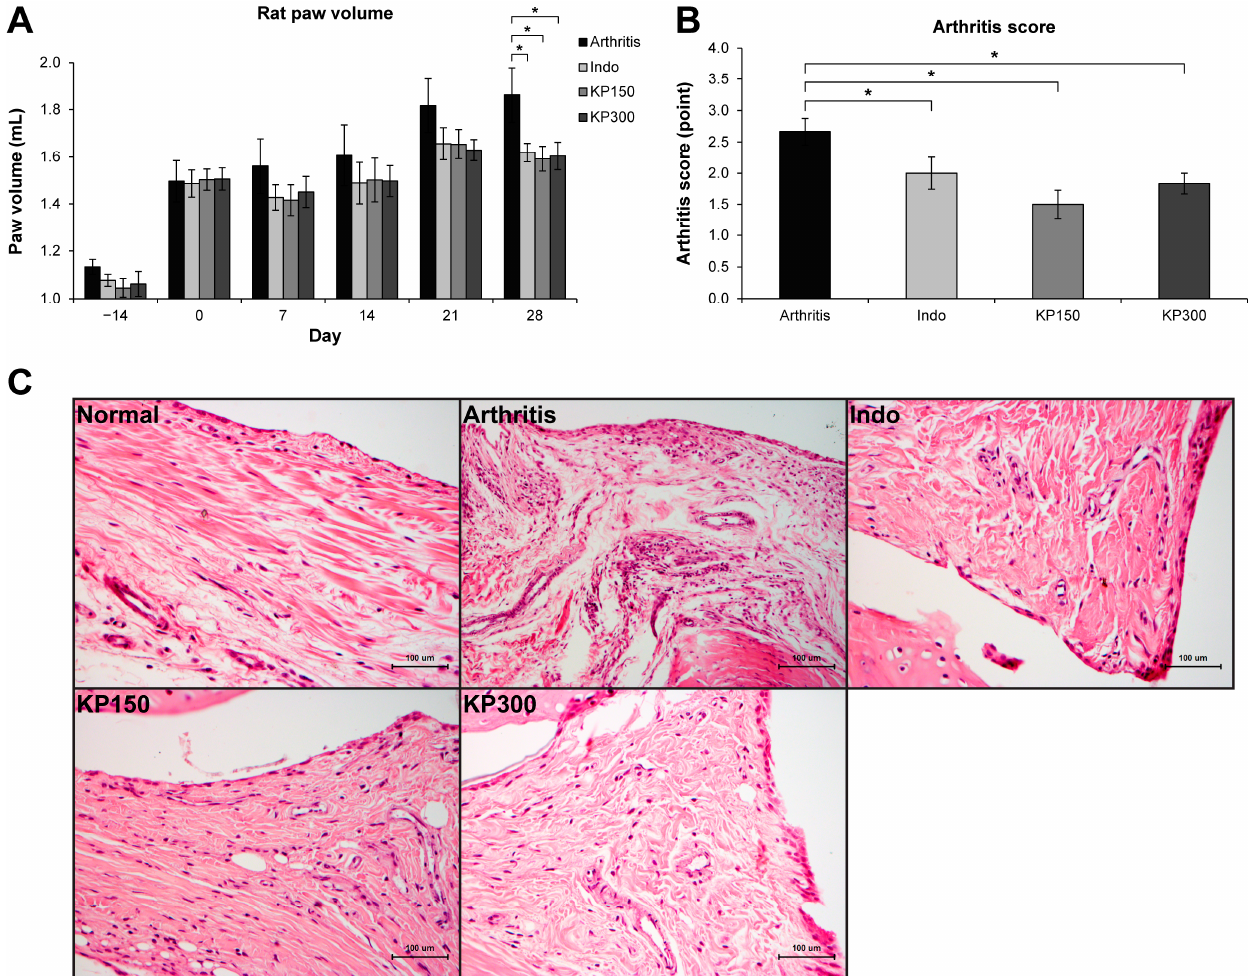
Figure 1. KP extract attenuates CFA-induced rat arthritis. ( A ) A graph shows an increase in the right paw volume of all groups on day 0, indicating the onset of an experimental RA induced by CFA injection. Then, the induced rats were fed with 3 mg/kg/day of indomethacin (Indo), 150 mg/kg/day of KP extract (KP150), or 300 mg/kg/day of KP extract (KP300) for another 28 days. The results show that Indo, KP150, and KP300 relatively decreased rat paw edema since day 7 and significantly on day 28, compared to the arthritis control group (Arthritis). ( B ) A significant reduction of arthritis severity scores, which were evaluated on day 28, was observed in the arthritis rats treated with Indo, KP150, and KP300, when compared with the arthritis control. ( C ) The H&E-Scheme 150. and KP300 groups. Results represent mean ± SEM of 3 rats (normal group) or 6 rats (treated groups). One-way ANOVA followed by the post hoc Fisher’s test was used to analyze the statistical difference (* p < 0.05).